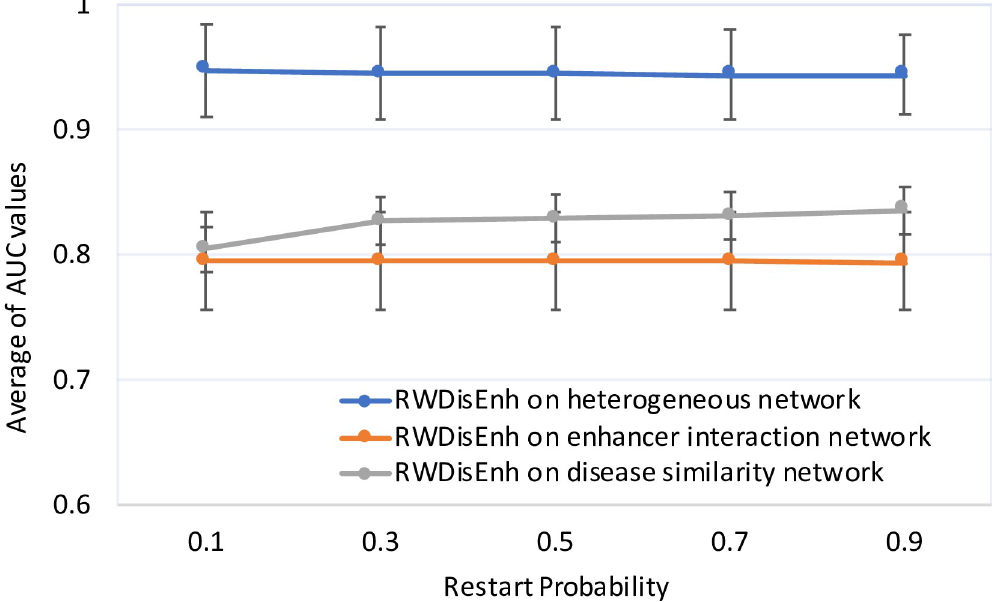
Fig 3. Performance comparison of RWDisEnh on the heterogeneous network of diseases and enhancers and that on the enhancer functional interaction network and the disease similarity network. λ and η are set to 0.5 for RWDisEnh running on the heterogeneous network of diseases and enhancers, γ is varied in {0.1, 0.3, 0.5, 0.7, 0.9} for the three networks. Average AUC values and standard errors were calculated based on the set of diseases/enhancers for each data point.